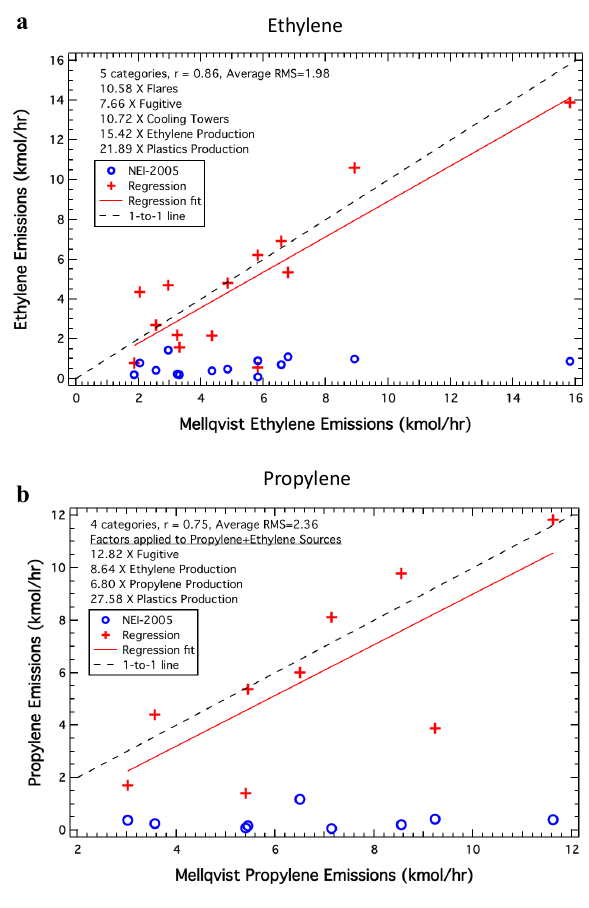
Figure 11. Updated and default ethylene and propylene emissions in NEI-2005 in comparison 4 Fig. 11. Updated and default ethylene and propylene emissions in with emission estimates by Mellqvist et al. (2010). 5 NEI-2005 in comparison with emission estimates by Mellqvist et al.